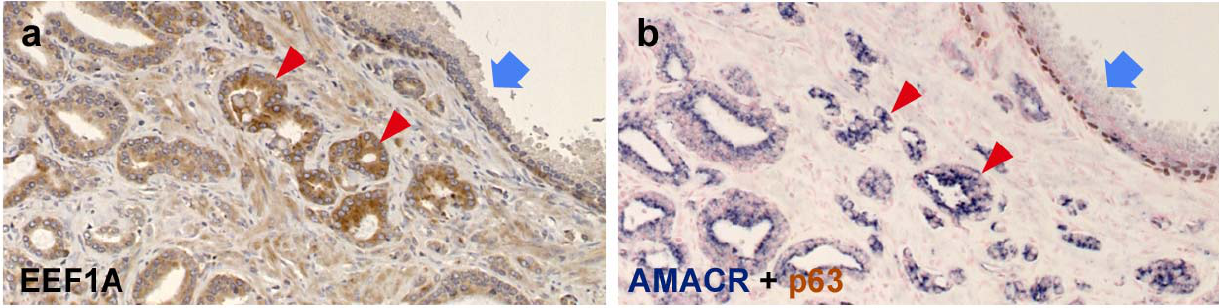
Figure 3. Immunohistochemical localization of EEF1A and other biomarkers in prostate tissues. (a) Representative image of the EEF1A immunostaining of prostate